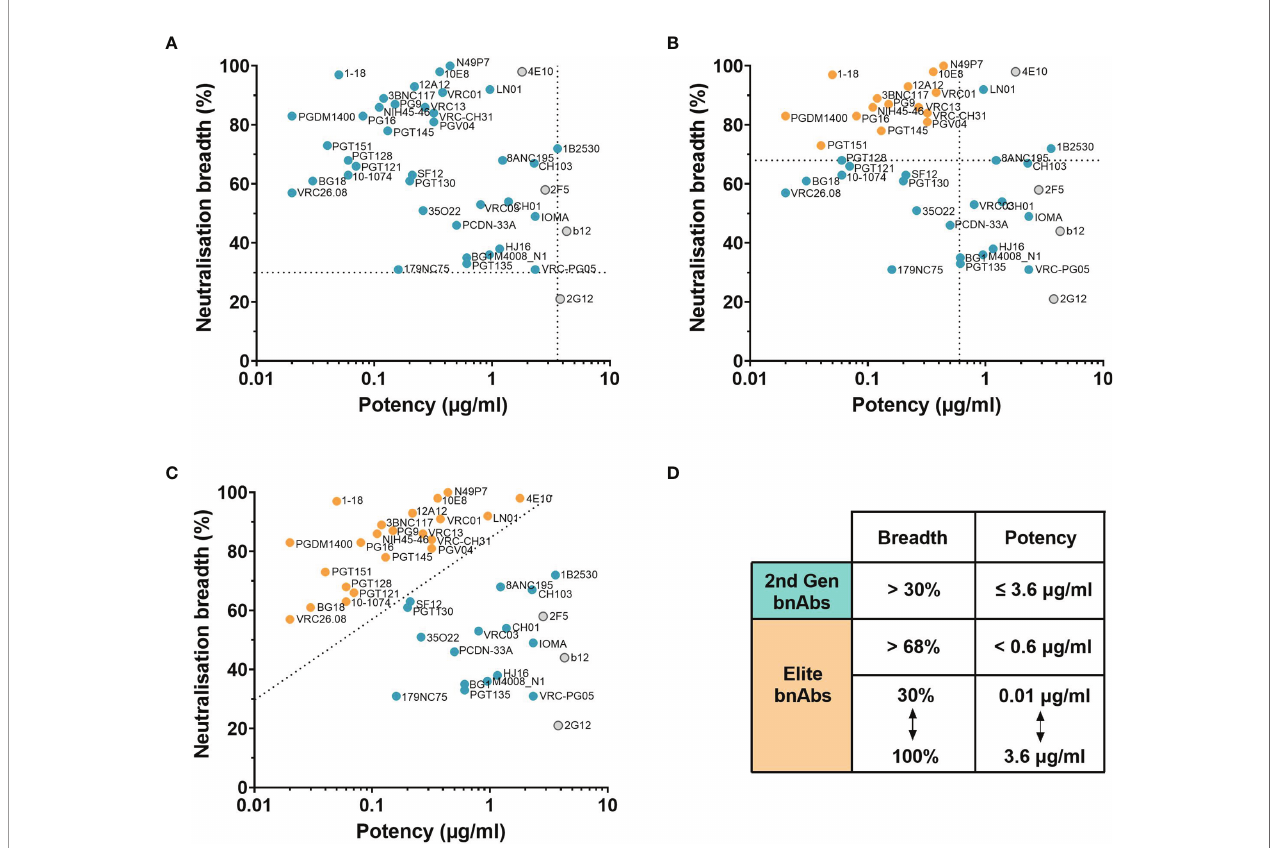
FIGURE 2 | Neutralisation breadth and potency of HIV bnAbs against the 118 multi-clade PV panel. (A – C) First generation bnAbs isolated prior to 2009 are shown in grey and second generation bnAbs isolated after 2009 are shown in blue. (A) Dashed lines at 30% neutralisation breadth and potency (geometric mean IC 50 ) of 3.6 µg/ml de fi ne the minimum bnAb thresholds for second generation bnAbs (blue circles). (B) Dashed lines at 68% neutralisation breadth and potency (geometric mean IC 50 ) of 0.6 µg/ml de fi ne elite bnAbs (orange circles). (C) The diagonal dashed line ranging from 30% to 100% neutralisation breadth and 0.01 µg/ml to 3.6 µg/ ml potency (geometric mean IC 50 ) compensates lower neutralisation breadth with lower potency to de fi ne elite bnAbs (orange circles). (D) Summary of the criteria that categorises second generation (2 nd Gen) bnAbs in (A) and elite bnAbs in (B, C)